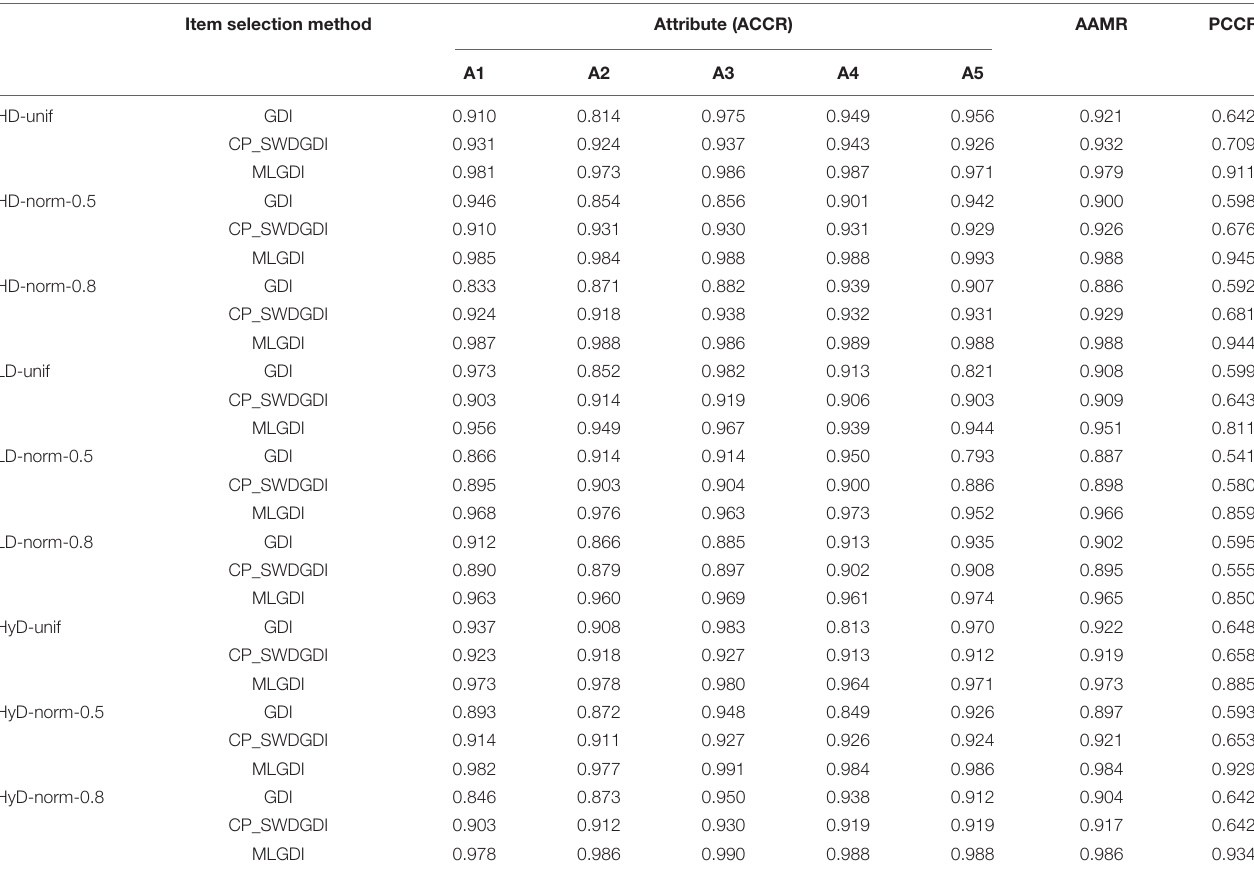
TABLE 4 | Accuracy of the attribute classification for five attributes. Item selection